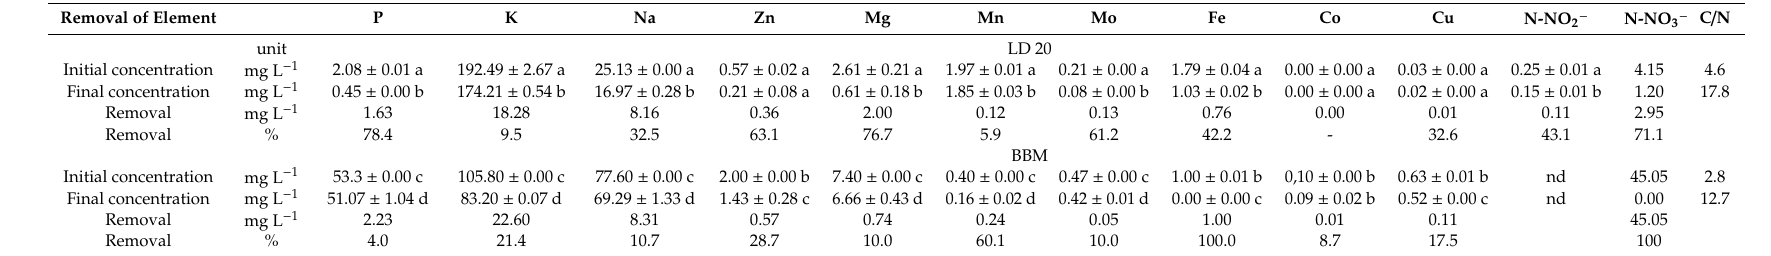
Table 3. Removal of macro and microelements by A. protothecoides from the liquid digestate (LD 20) and BBM